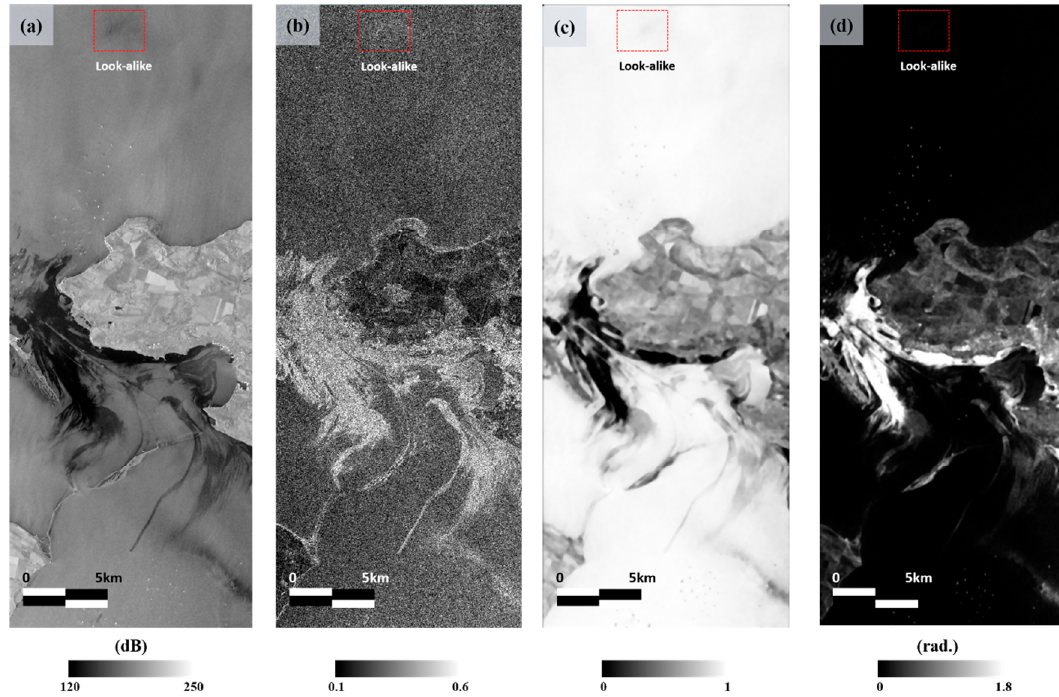
Figure 8. Inputs for the artificial neural network (ANN) with the look-alike region denoted by the red box and the ship pixel marked by a dotted red box: ( a ) NL-means filtered intensity map; ( b ) normalized intensity texture map; ( c ) coherence map; and ( d ) phase texture map.